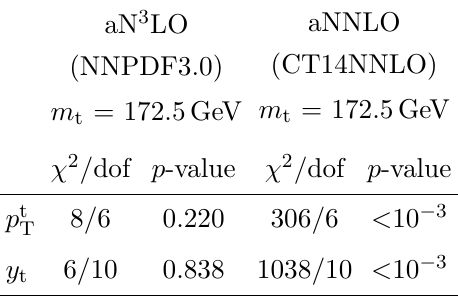
Table 53 . The (cid:31) 2 /dof and p -values quantifying the agreement between the two theoretical predic- tions with aN 3 LO and aNNLO precision and the measured, parton-level absolute cross sections are